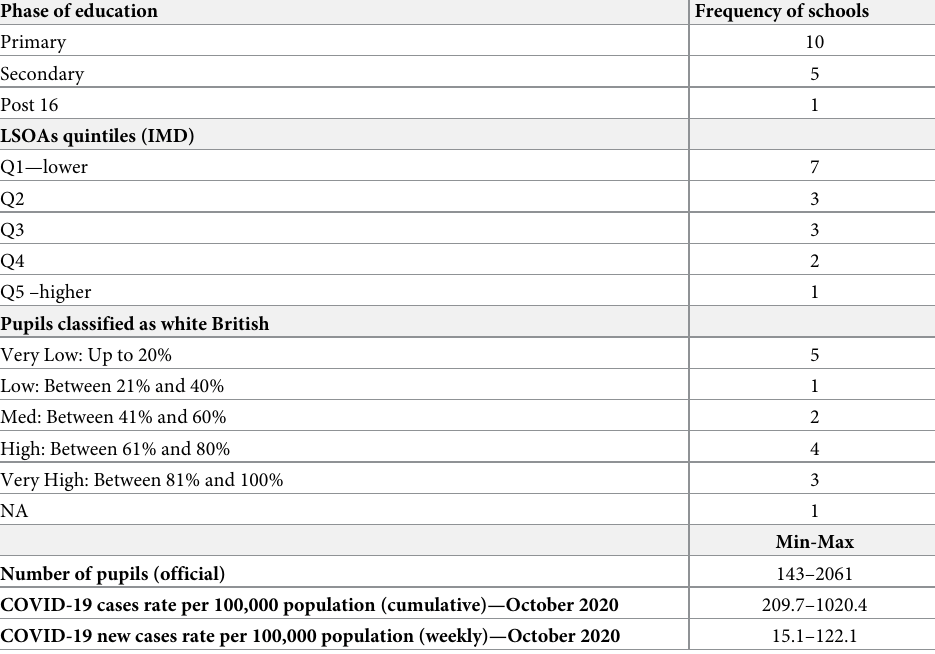
Table 1. Schools